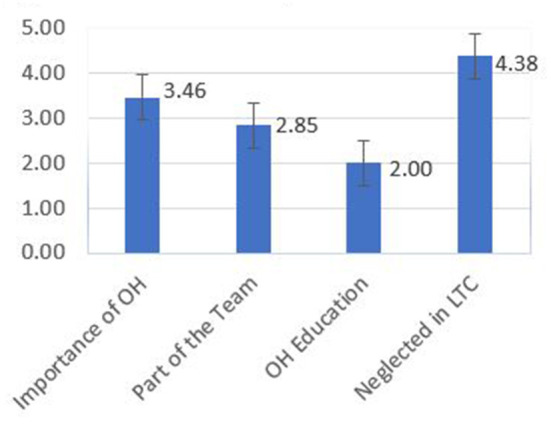
Initial survey results.